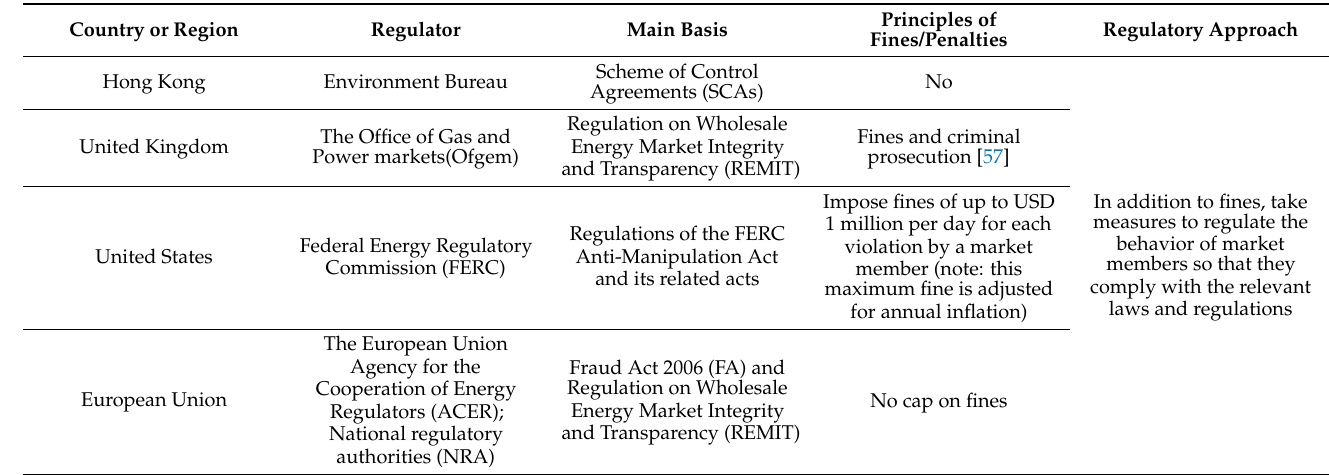
Table 2. Regulatory measures of manipulative behavior in the power market for Hong Kong, the United Kingdom, the United States and the European